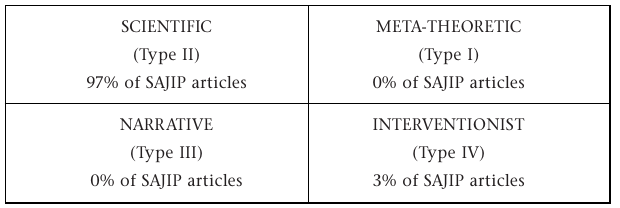
Figure 4: I/O Psychology research meta-types (1994 –